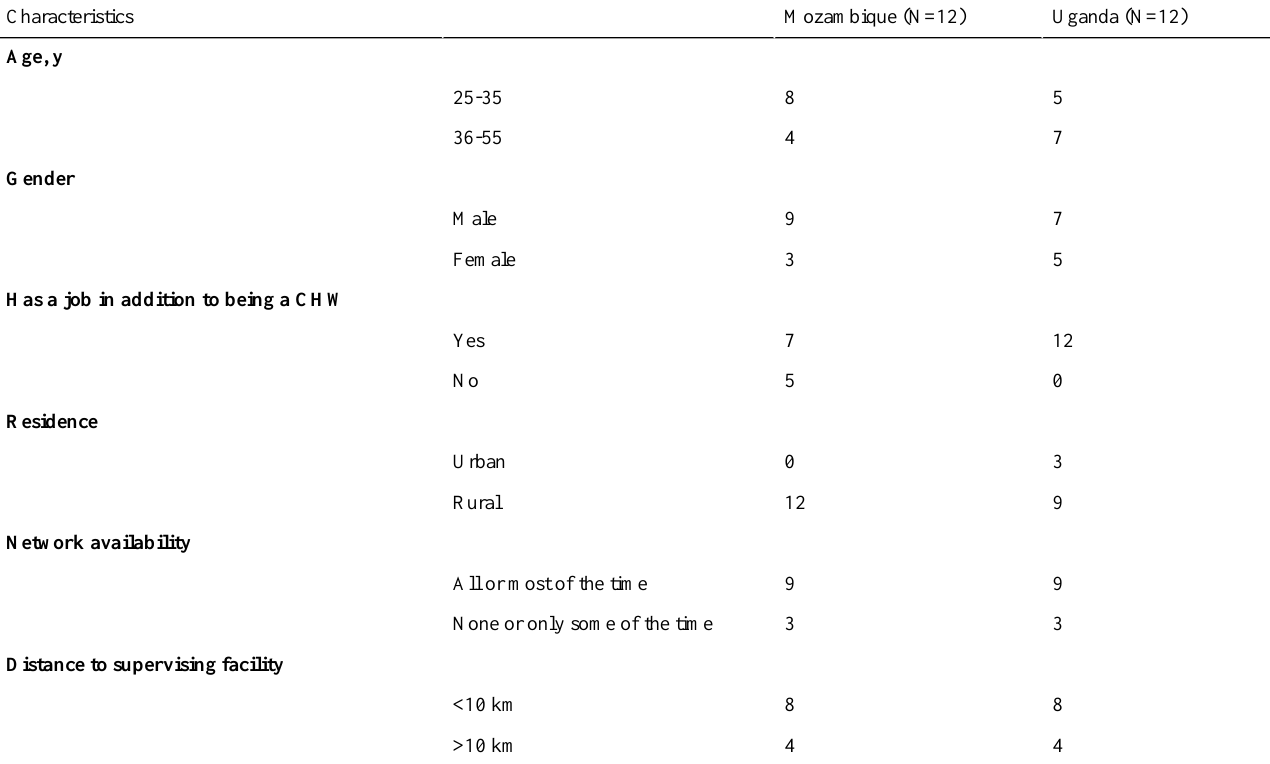
Table 1. Sample size and characteristics of the CHWs who were selected for in-depth interviews at each